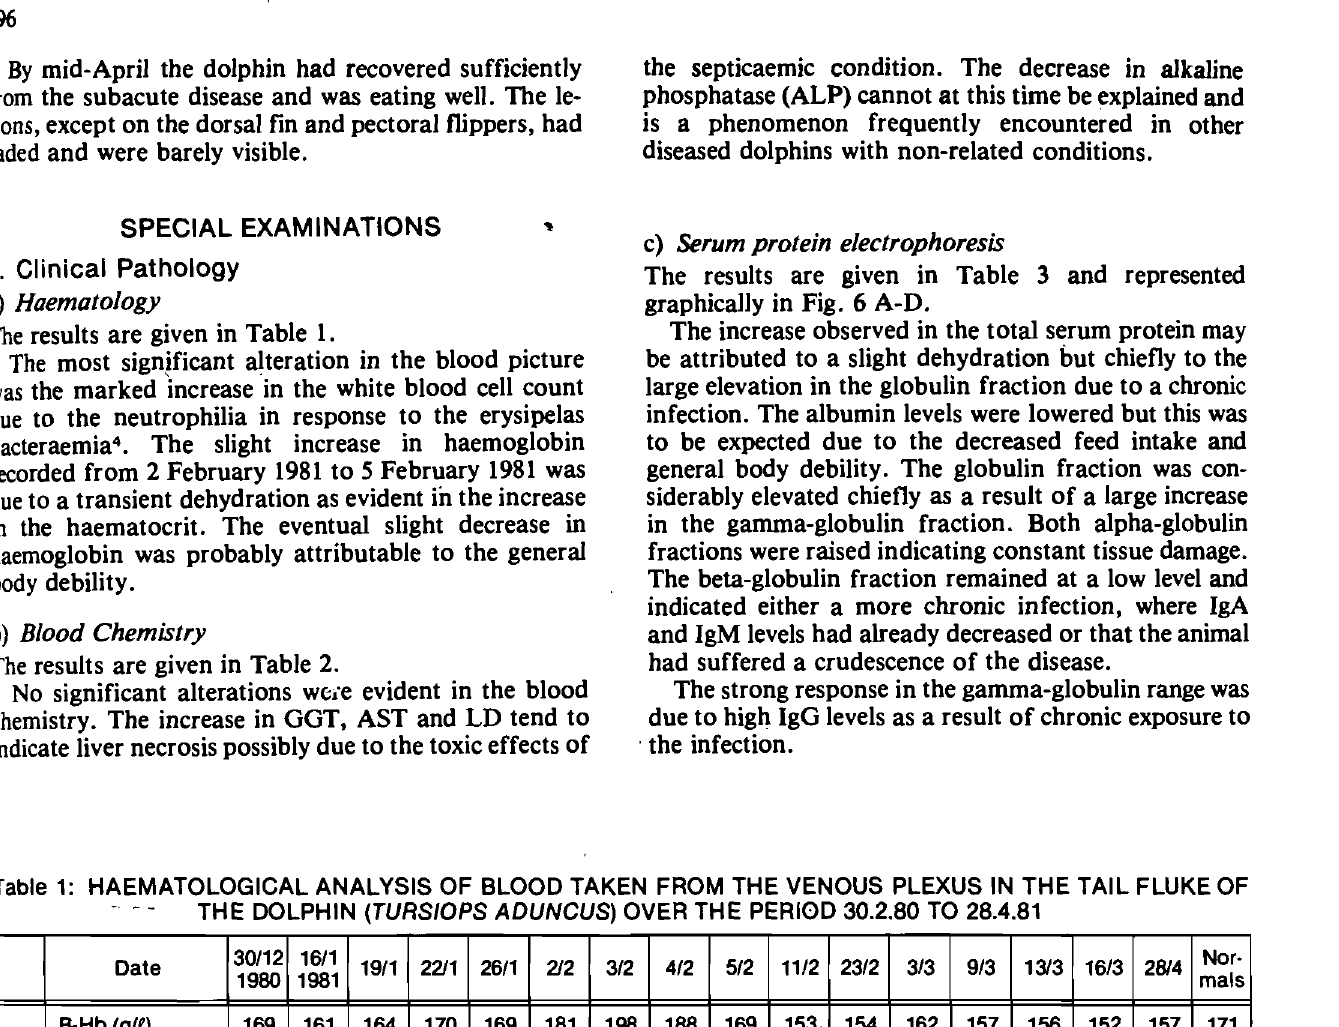
Table 1: HAEMATOLOGICAL ANALYSIS OF BLOOD TAKEN FROM THE VENOUS PLEXUS IN THE TAIL FLUKE